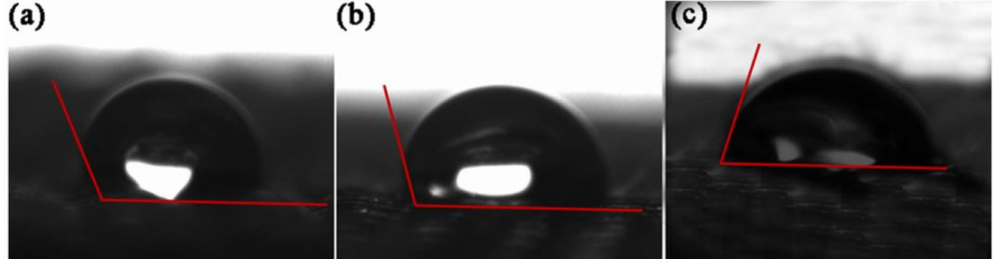
Figure 9. Images of contact angle between TBC and ( a ) PF fabric, ( b ) PF-1 fabric, and ( c ) PF-2